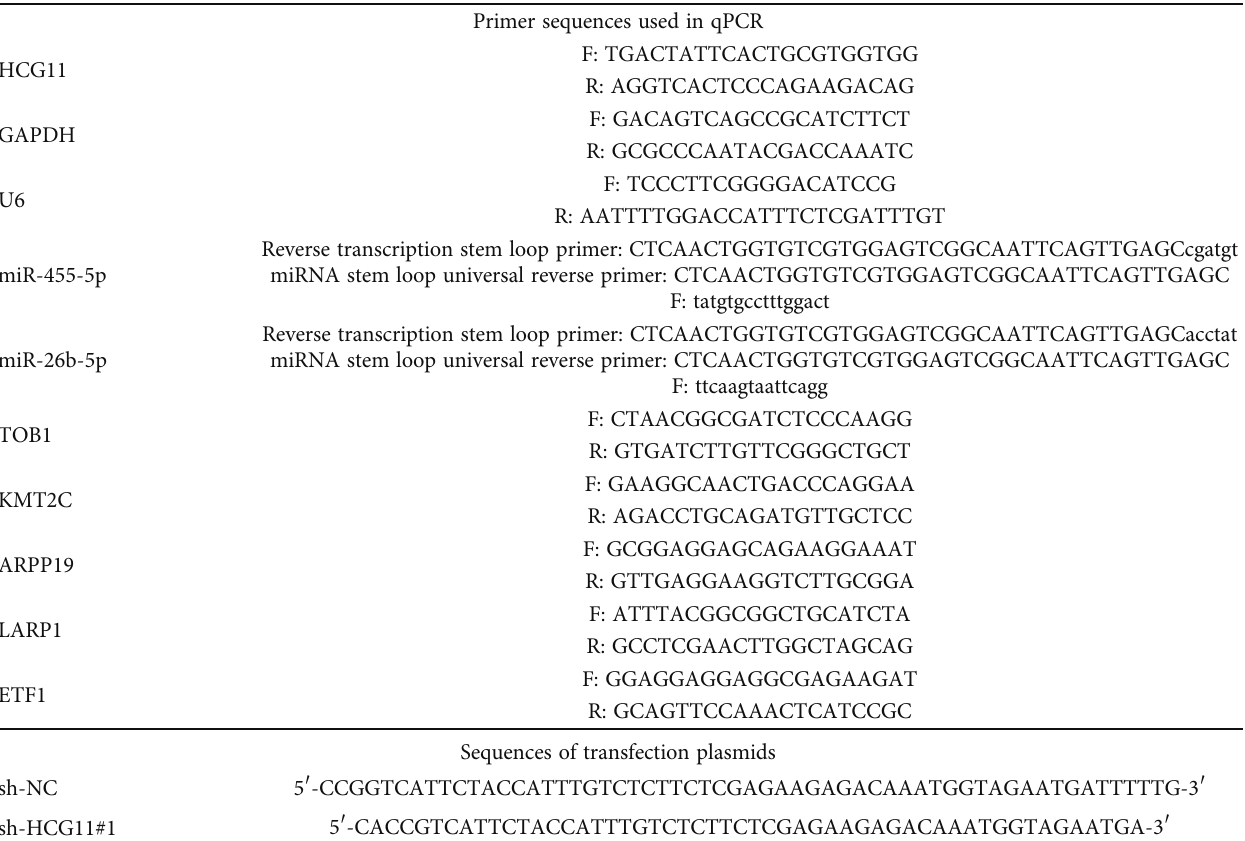
Table 1: Primer sequences used in qRT-PCR and sequences of transfection plasmids. Primer sequences used in